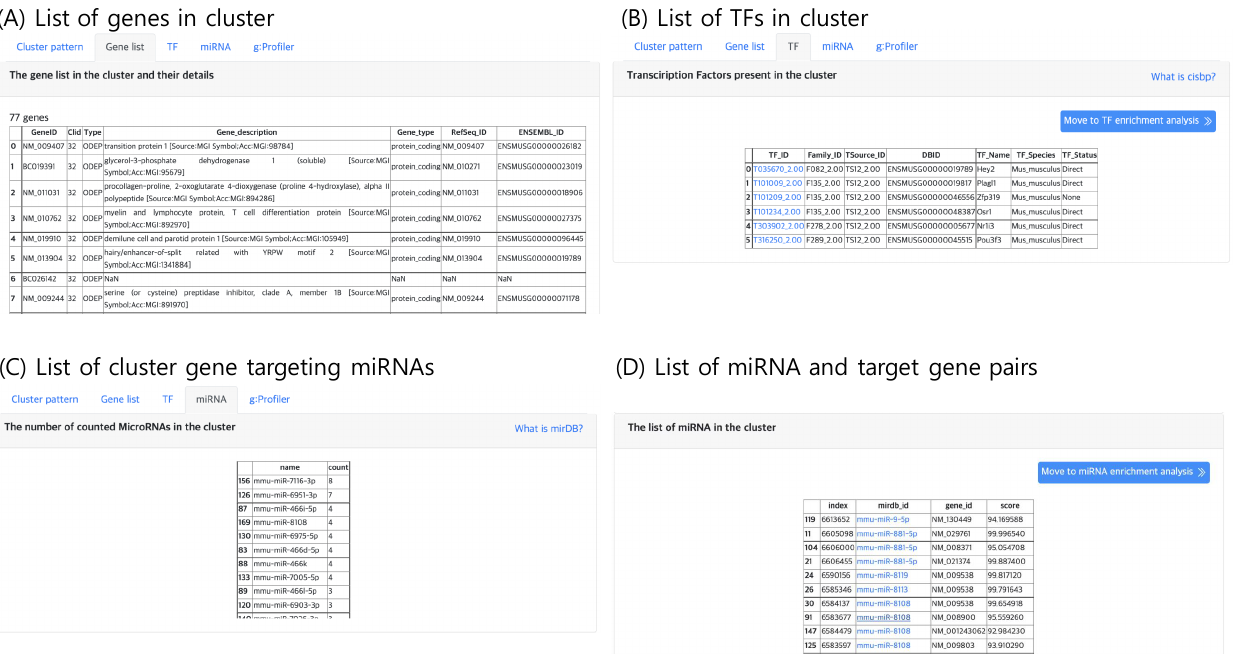
Figure 6. The result tabs showing ( A ) the gene list in a cluster ( B ) TFs present in a cluster ( C ) Number of counted miRNAs in a cluster and ( D ) the list of miRNAs and their target genes in a